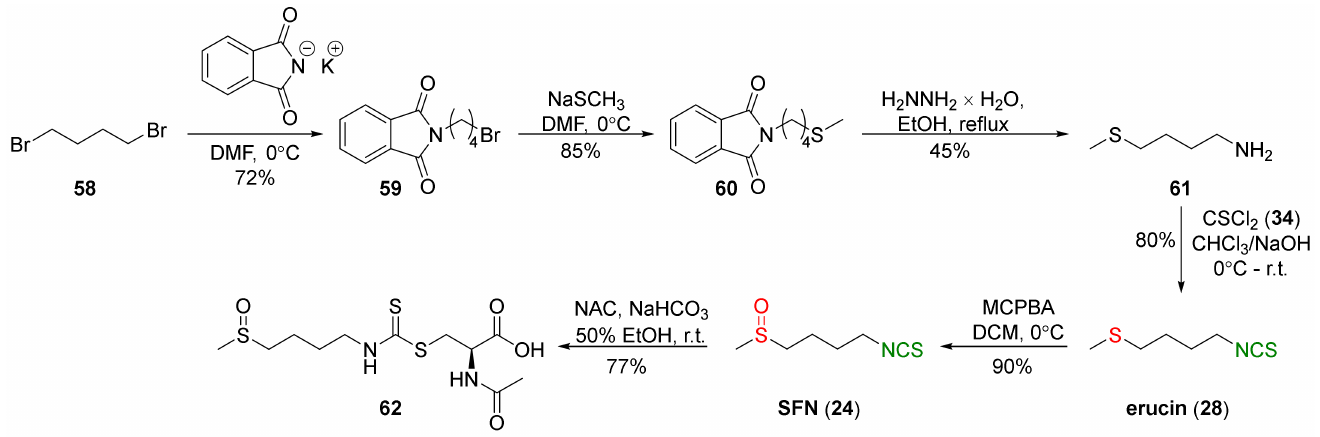
Figure 15. Synthesis of SFN ( 24 ) and its mercapturic acid 62